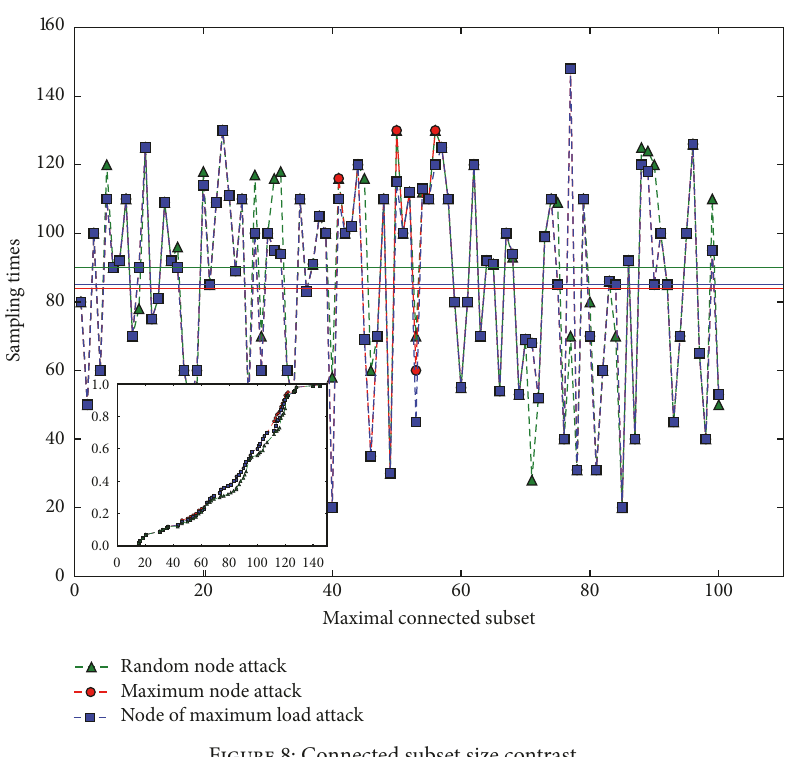
Figure 8: Connected subset size